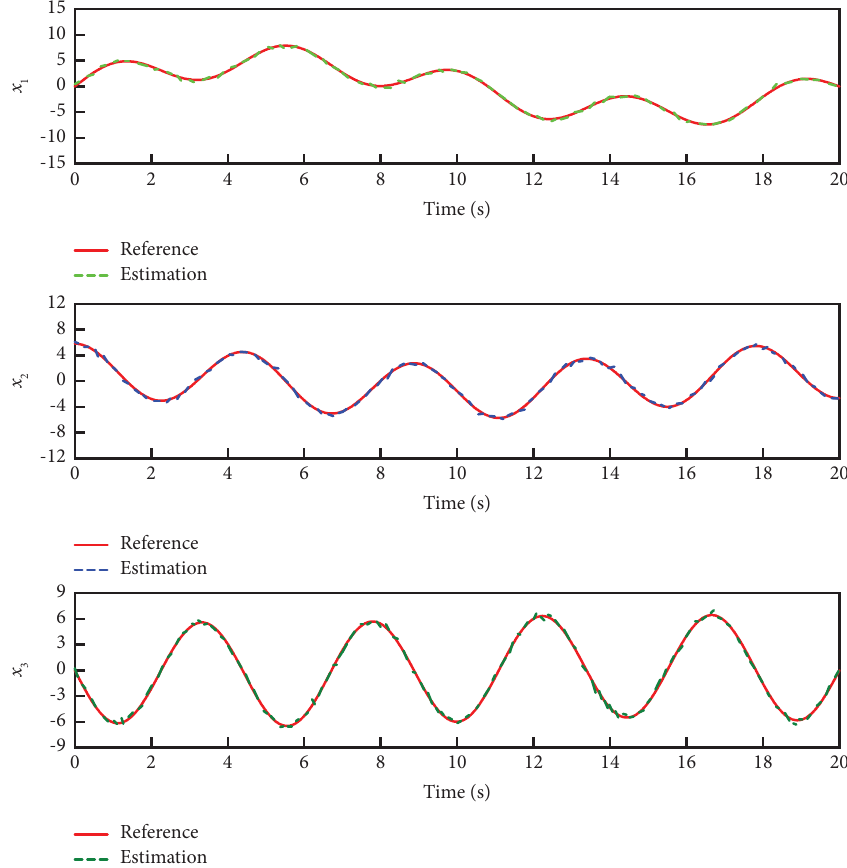
Figure 11: State variables estimation results of multifrequency sinusoidal signal.